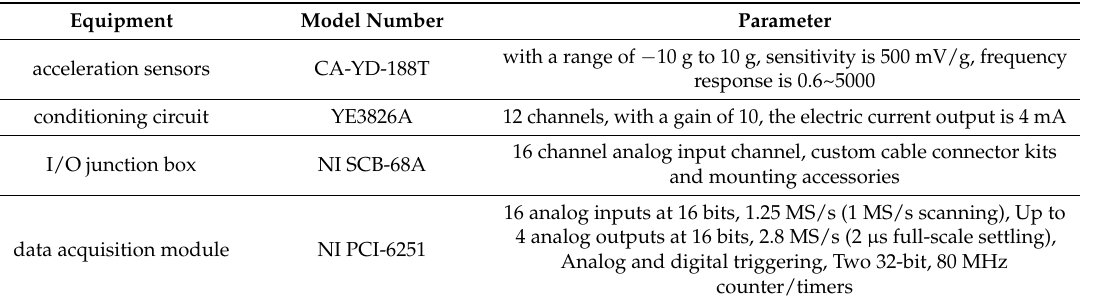
Figure 7. Experimental system. Table 4. Experimental installation parameters.